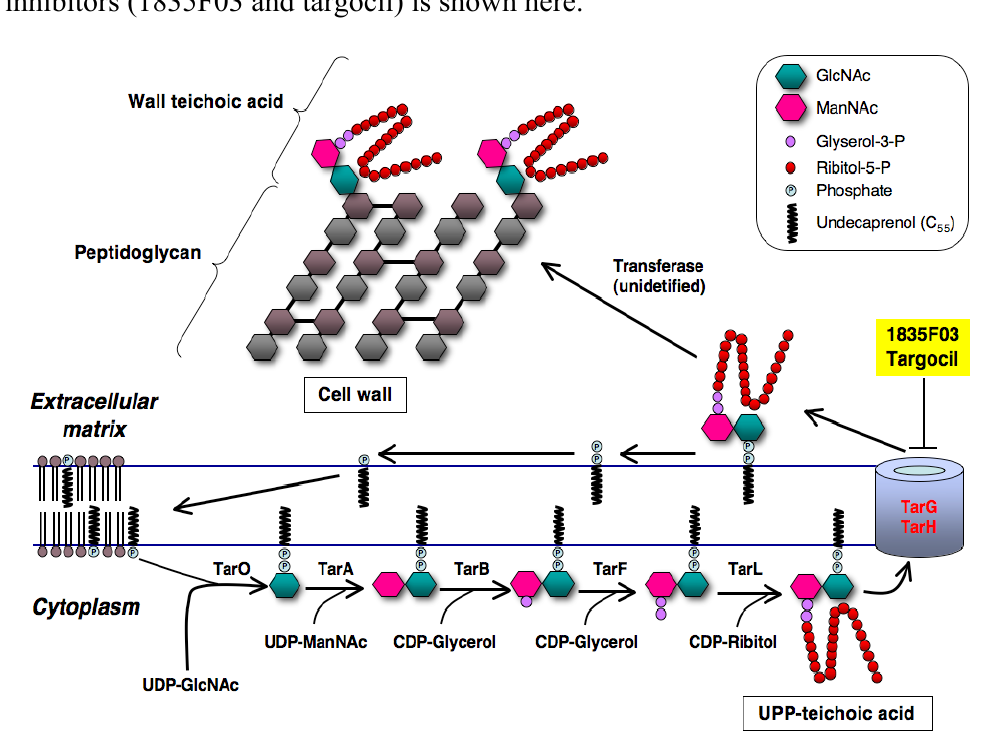
Figure 10. Biosynthetic pathway of wall teichoic acid of S. aureus . The inhibition site of new inhibitors (1835F03 and targocil) is shown